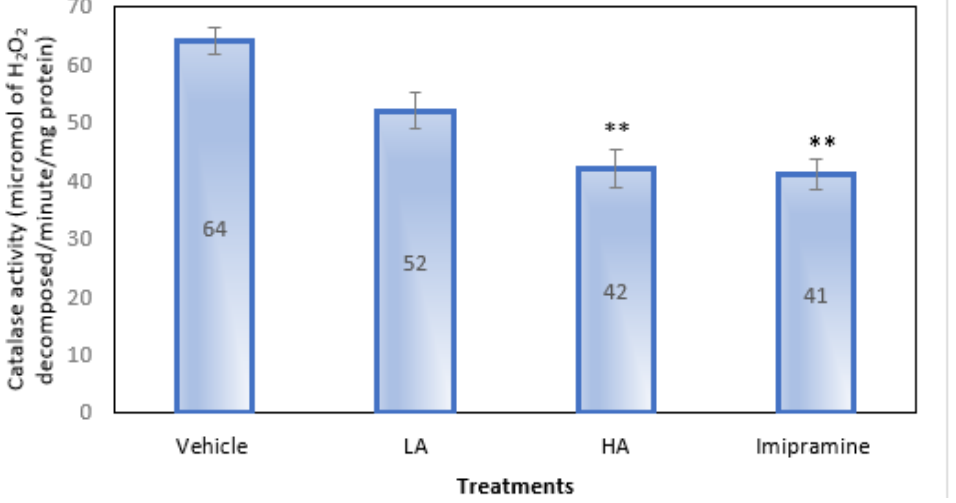
Figure 6. The effect of apigenin and imipramine on brain catalase activity. Data are expressed in mean ± SEM (n = 8). Data were evaluated using a one-way analysis of variance (ANOVA) and Tukey ’ s test. ** p < 0.01 when compared to the vehicle control group. LA: low dose of Apigenin (25 mg/kg); HA: high dose of Apigenin (50 mg/kg); Imipramine: standard antidepressant (15 mg/kg); Vehicle; 0.2% carboxy methyl cellulose (CMC).